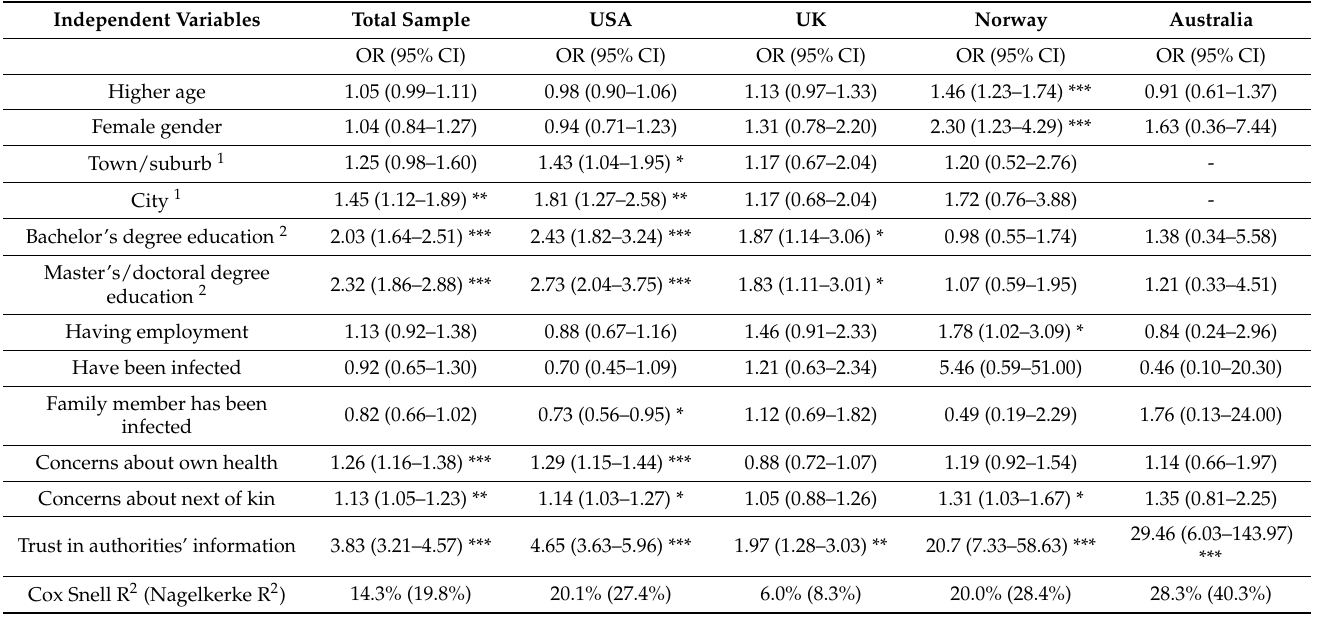
Table 2. Adjusted associations with being likely or very likely to take the COVID-19